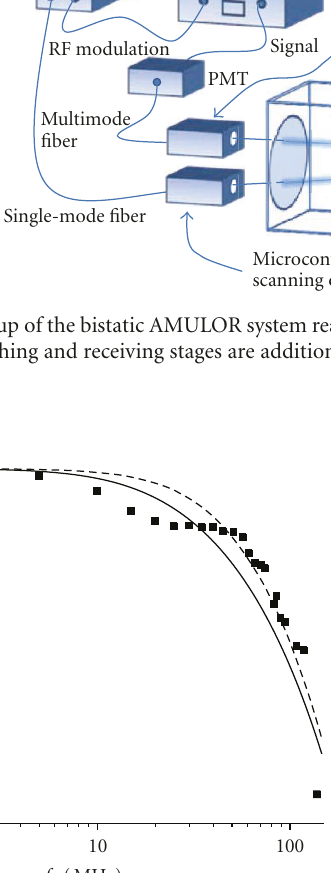
= 0 . 66m − 1 , k f = 0m − 1 s s